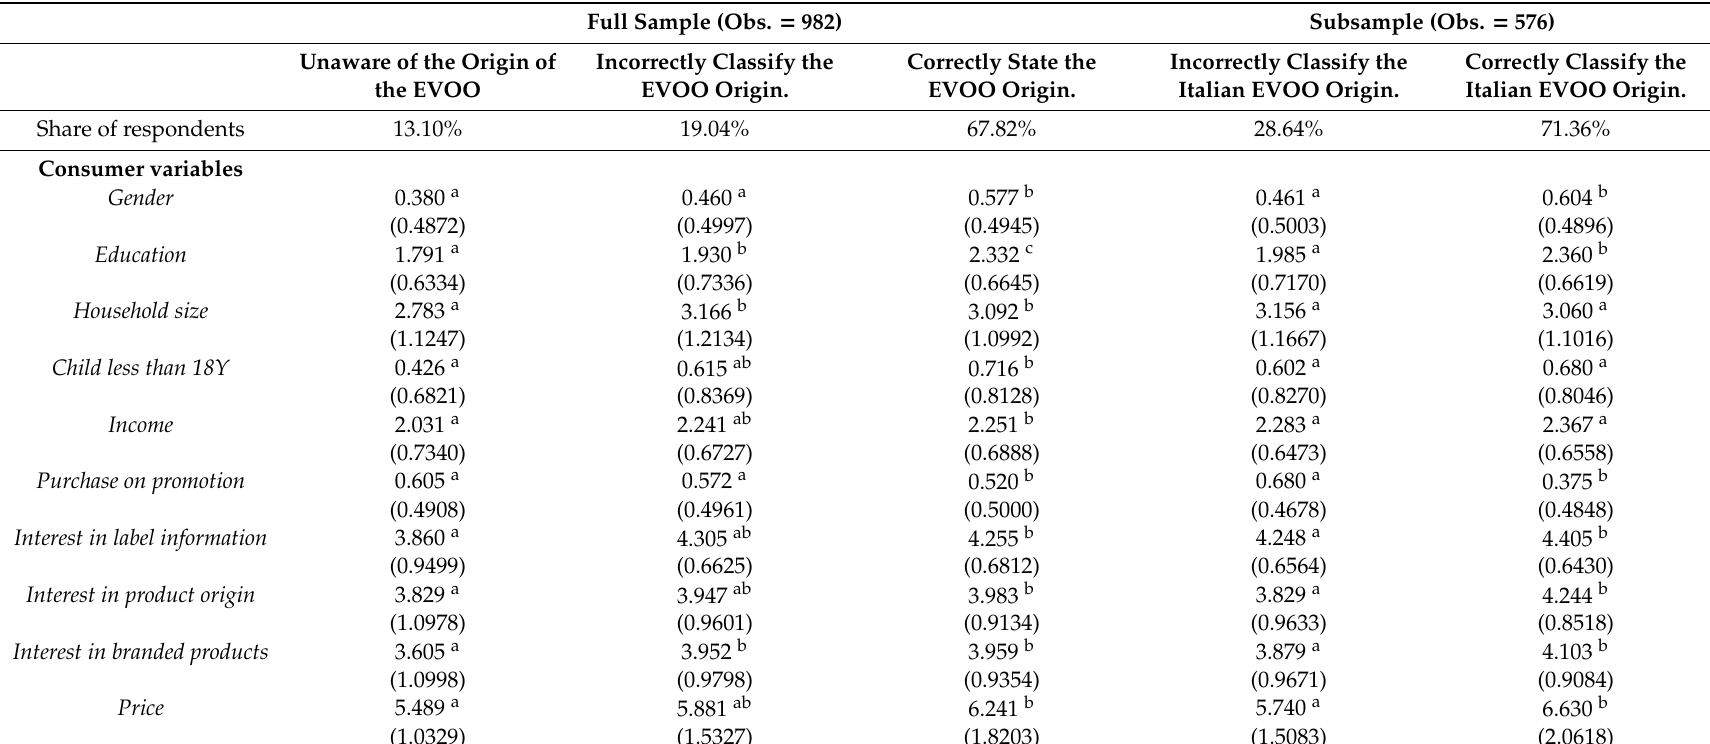
Table 4. Characteristics of consumers